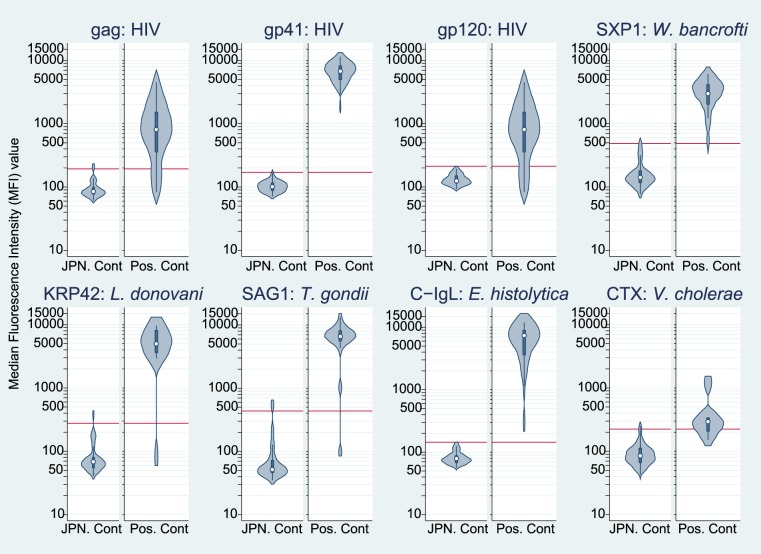
Serum reactivity by the multiplex assays for 8 antigens among healthy Japanese and clinically diagnosed positive sera: HIV (gag, gp41and gp120), W. bancrofti (SXP1), L. donovani (KRP42), T. gondii (SAG1), E. histolytica (C-IgL), and V. cholerae (CTX) antigens.Red horizontal lines represent cut-off values calculated as the means plus three standard deviations (SDs) of the distributions of median fluorescence intensity (MFI) values of 40 healthy Japanese serum samples.